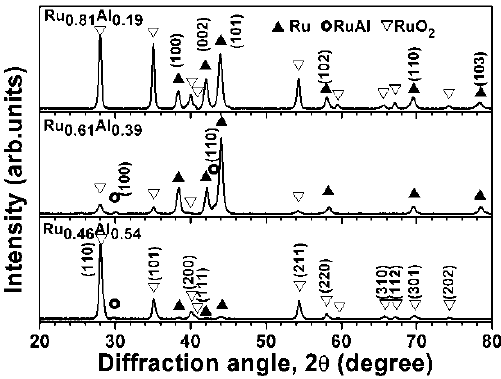
Figure 9. XRD patterns of the Ru–Al thin films prepared on Inconel 617 substrates with a Ru interlayer and annealed in air at 800 °C for 30 min.